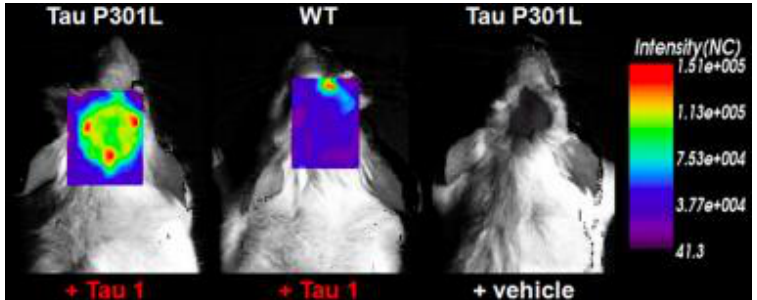
Figure 10. In vivo fluorescence imaging of a tau deposition in Tau P301L and wild-type mouse brain after the injection of either Tau 1 or the vehicle (negative control) [104]. The images were acquired using 670-nm excitation light 30 min after the injection of the molecular imaging probe. Images are reprinted with permission of the publisher [104].